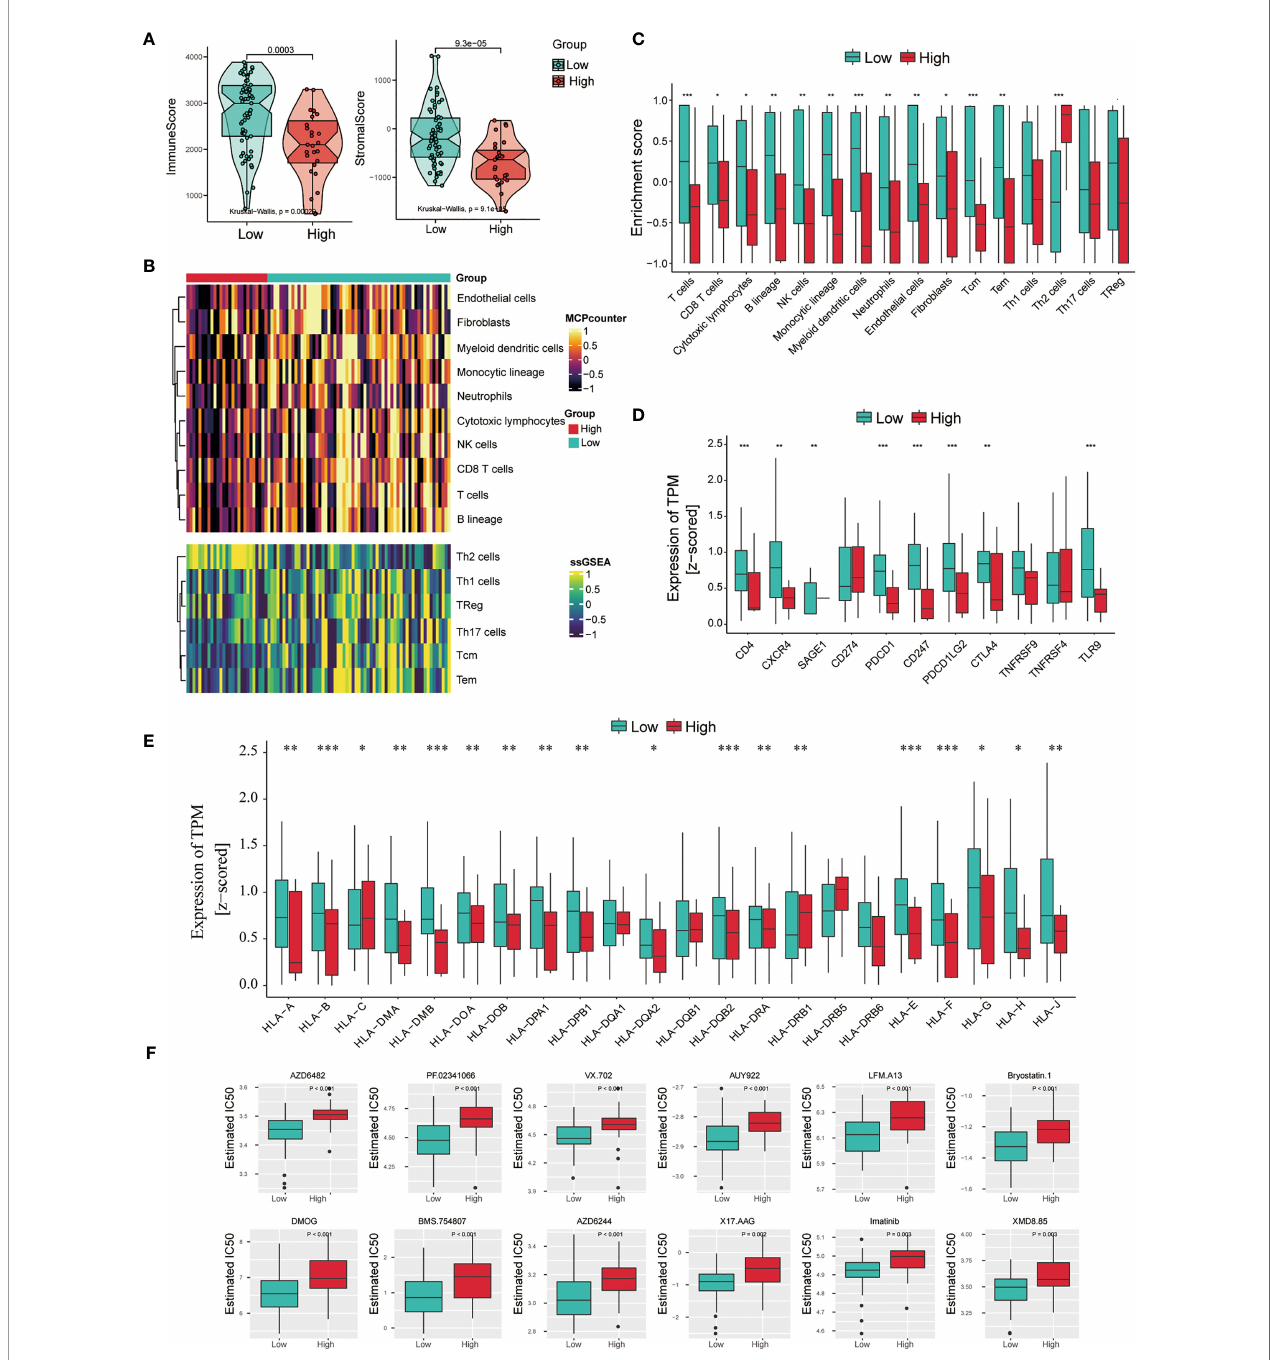
FIGURE 6 | Association between immune in fi ltration and NSUN2 expression in NPC. (A) Boxplot of the ImmuneScore and StromalScore from ESTIMATE of the NSUN2 high and low expression groups. (B) Heatmap of the abundance of immune and stromal cell populations in the NSUN2 high and low expression groups. (C) Boxplot of the enrichment score of the immune cells in these two groups. (D) Expression level of 11 immune checkpoint genes and (E) HLA genes in two groups. (F) The sensitivity of chemotherapeutic drugs in the NSUN2 high and low expression groups. * P < 0.05, ** P < 0.01, and *** P <